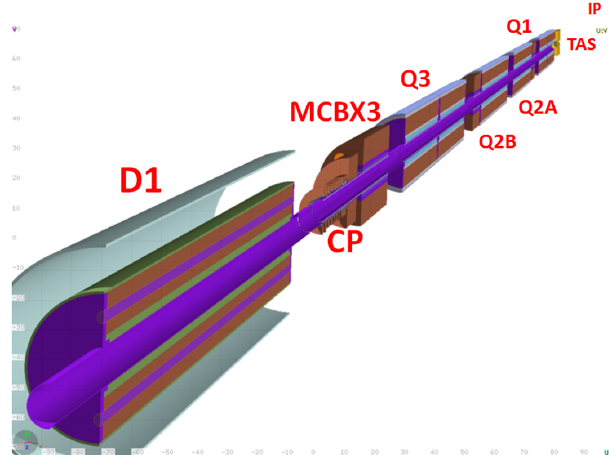
FIG. 2. Computer model of HiLumi LHC inner triplet with correctors MCBX/CP and D1